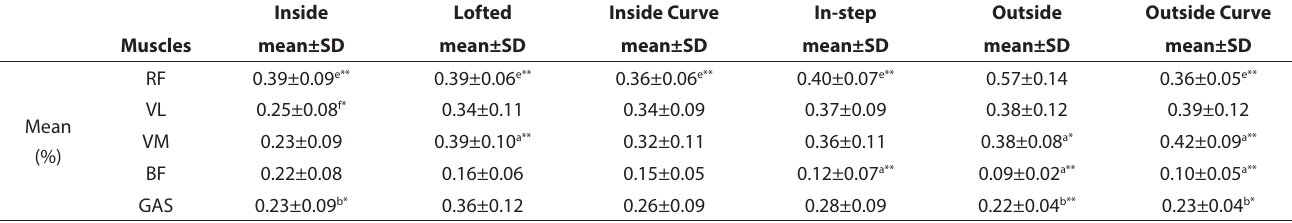
TABLE 4 Mean normalized muscle activation from different kick types (% of MVIC) Inside Lofted Inside Curve In-step Outside Outside Curve Muscles